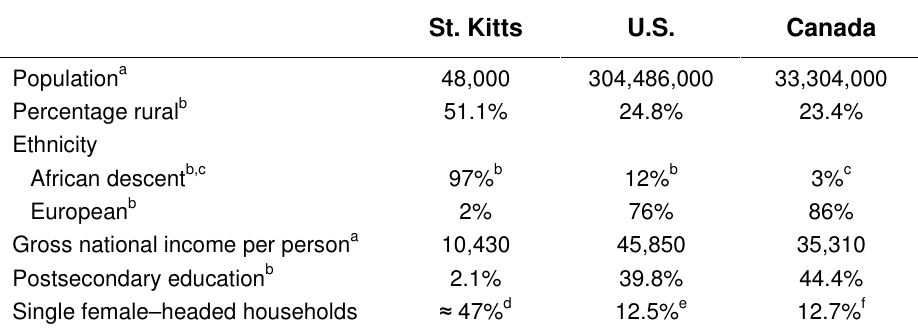
Demographic and Social Features of St. Kitts and Nevis, the U.S., and Canada St.